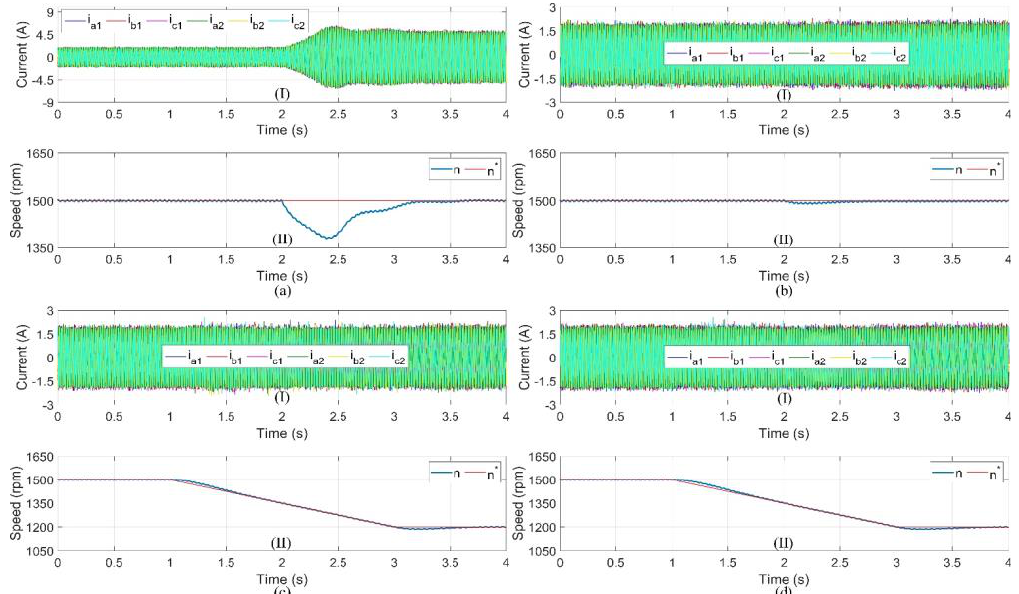
Figure 10. ASPIM under torque variation from 1.5 to 10.6 Nm in the healthy condition: (( a ) plots) ASPIM at 1.5 Nm with transient fault condition at 2 s, (( b ) plots) ASPIM in a speed transition from 1500 to 1200 rpm under the healthy condition, and (( c ) plots) ASPIM in a speed transition from 1500 to 1200 rpm under a faulty condition (( d ) plots). From top to bottom: (I) 𝑎 1 ,𝑏 1 ,𝑐 1 ,𝑎 2 ,𝑏 2 ,𝑐 2 phase currents, (II) motor speed.